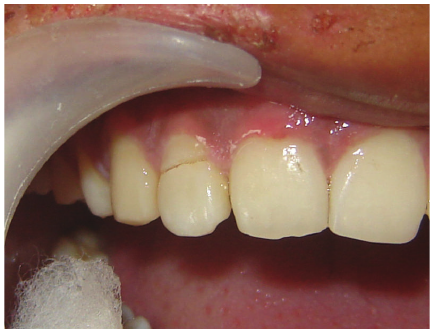
Figure 2: Fracture fragment removed from underlying tooth structure.